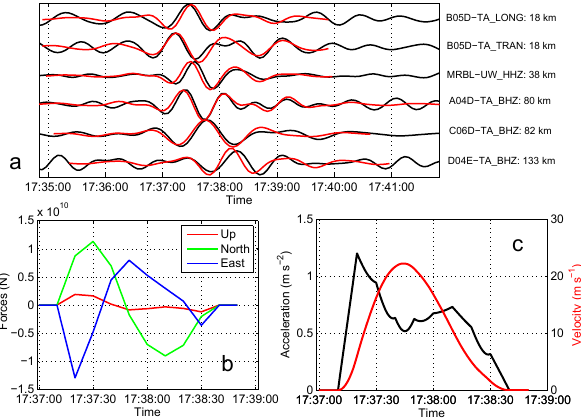
Figure 4. (a) Observed (black) and synthetic (red) long-period seis- mograms filtered between 40 and 150s for the first Oso-Steelhead landslide. The station name, component and distance to the land- slide are given to the right of each trace. (b) Landslide force his- tories inverted for the first Oso-Steelhead landslide. (c) Temporal evolution of the acceleration and the velocity of the centre of mass inferred from the integration of the inverted forces.